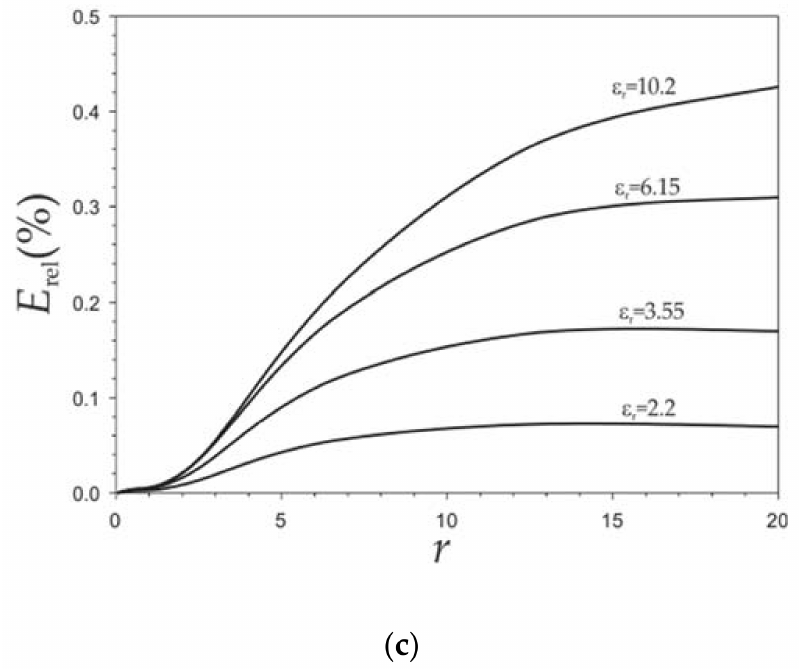
Figure 3. Dependence of ε eff ( a ), ε r , eq ( b ) and E rel ( c ) with r , as parametrized by ε r .